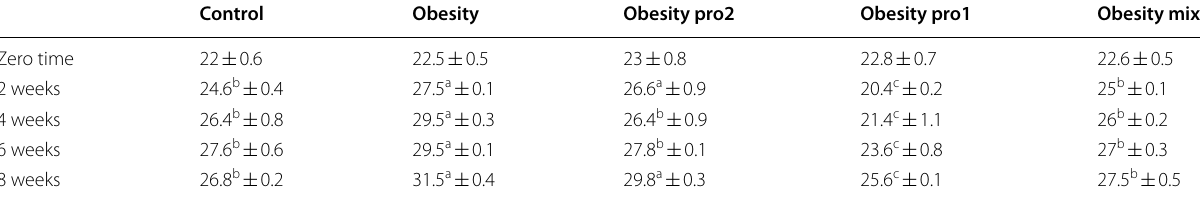
All data are expressed as the mean a,b,c Differ significantly at P < 0.05 Table 3 Lipid profile analysis